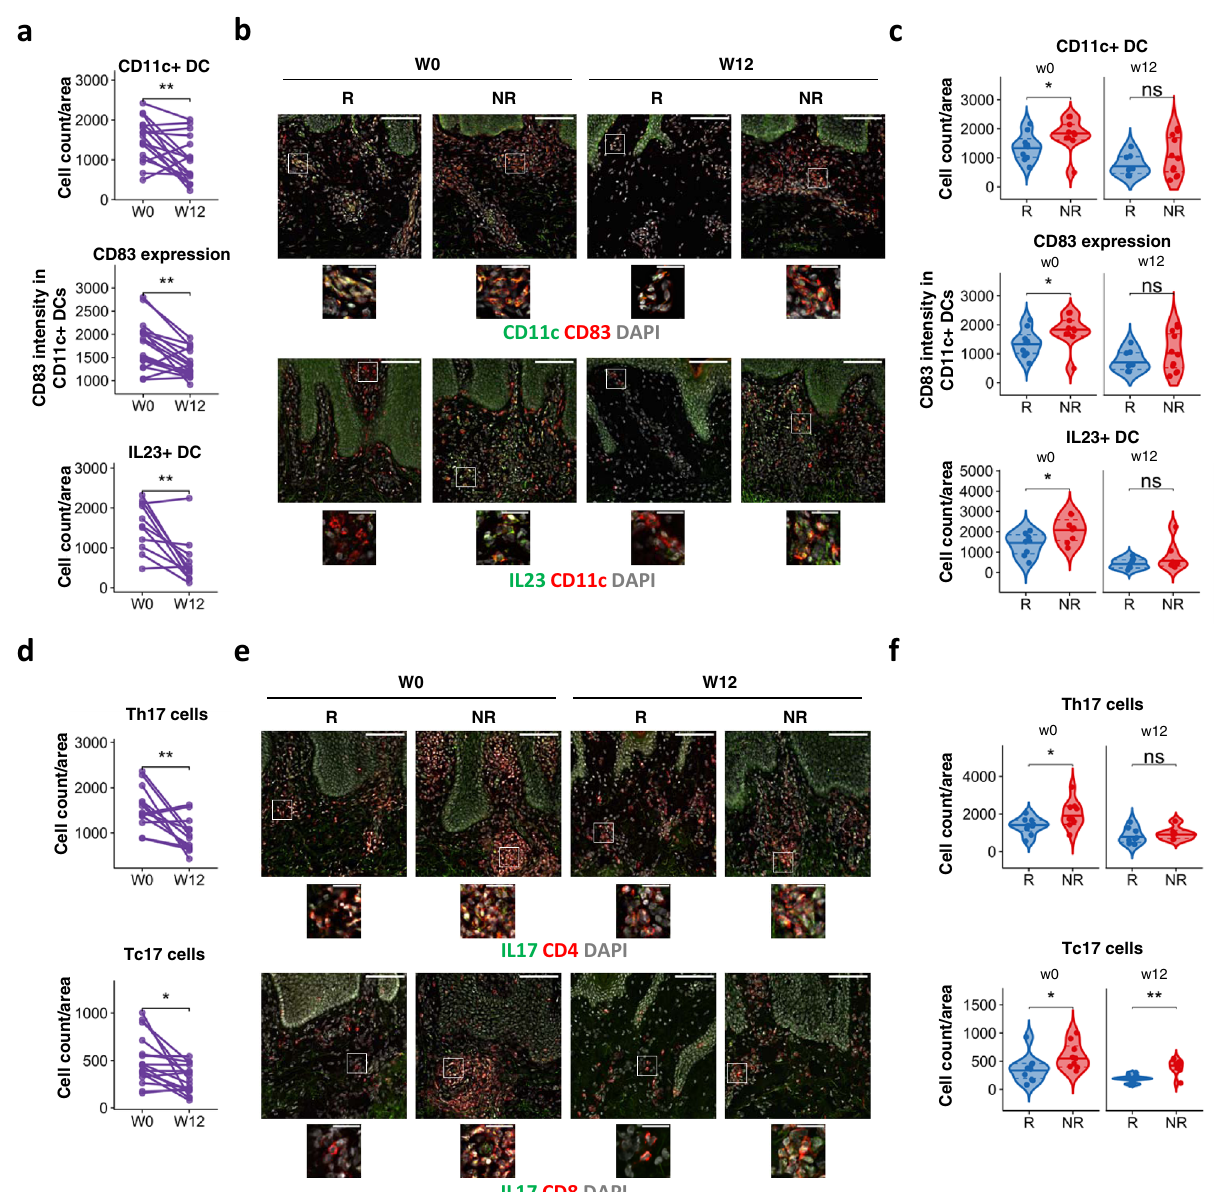
Fig. 5 Response to adalimumab is associated with DC and IL-17 + T cell activation. Analysis of psoriasis lesional skin of patients at baseline (w0) and after 12 weeks (w12) of adalimumab treatment a Number of CD11c + DCs, expression of CD83 in CD11c + dermal dendritic cells (DC) and number of IL- 23 + CD11c + DC per area of analysis (750 × 750 μ m) at different time points. Each line represents one patient ( n CD11c and CD83 = 17, n IL23 = 11) ( p CD11c = 0.0093, CD83 = 0.0012, IL23 = 0.0049). b Representative immuno fl uorescence images of psoriasis skin showing total number of CD11c + DCs (top), CD83 expression in CD11c + DC (middle) and IL23 + CD11c + DC (bottom) in PASI75 adalimumab responders ( R , n = 8 – 10) and non-responders (NR, n = 6 – 10). c Violin plot graphs of CD11c + DC counts (top), CD83 expression in dermal DC (middle) and number of IL23 + DC in adalimumab responders (blue, n = 8 – 10) and non-responders (red, n = 6 – 10) at w0 and w12) ( p CD11c = 0.043, CD83 = 0.035, IL23 = 0.039). d Number of IL-17A + CD4 + Th17 and IL-17A + CD8 + Tc17 cells per area of analysis at different time points. Each line represents one patient ( n Th17 = 13, n Tc17 = 17) ( p Th17 = 0.0013, Tc17 = 0.011). e Representative immuno fl uorescence images of psoriasis skin showing Th17 (top) and Tc17 (bottom) in adalimumab responders ( n = 8 – 10) and NR ( n = 6 – 9). f Violin plot graphs of the number of Th17 and Tc17 cells in lesional skin sections of in adalimumab responders (blue, n Th17 week 0 = 9, n Th17 week 12 = 8, n Tc17 week 0 = 10, n Tc17 week 12 = 9) and non-responders (red, n Th17 week 0 = 9, n Th17 week 12 = 6, n Tc17 week 0 = 9, n Tc17 week 12 = 8) at w0 and w12 ( p Th17 = 0.04, Tc17 w0 = 0.028, Tc17 w12 = 0.0037). Wilcoxon test ( a bottom panel), or paired t test ( a except bottom panel, d ), Mann – Whitney U test ( c top panel, f ) or unpaired t test ( c except top panel). All tests are two-sided. Scale bars in ( b , e ): 100 µ m (overview) and 25 µ m (insets). Source data are provided as a Source Data fi